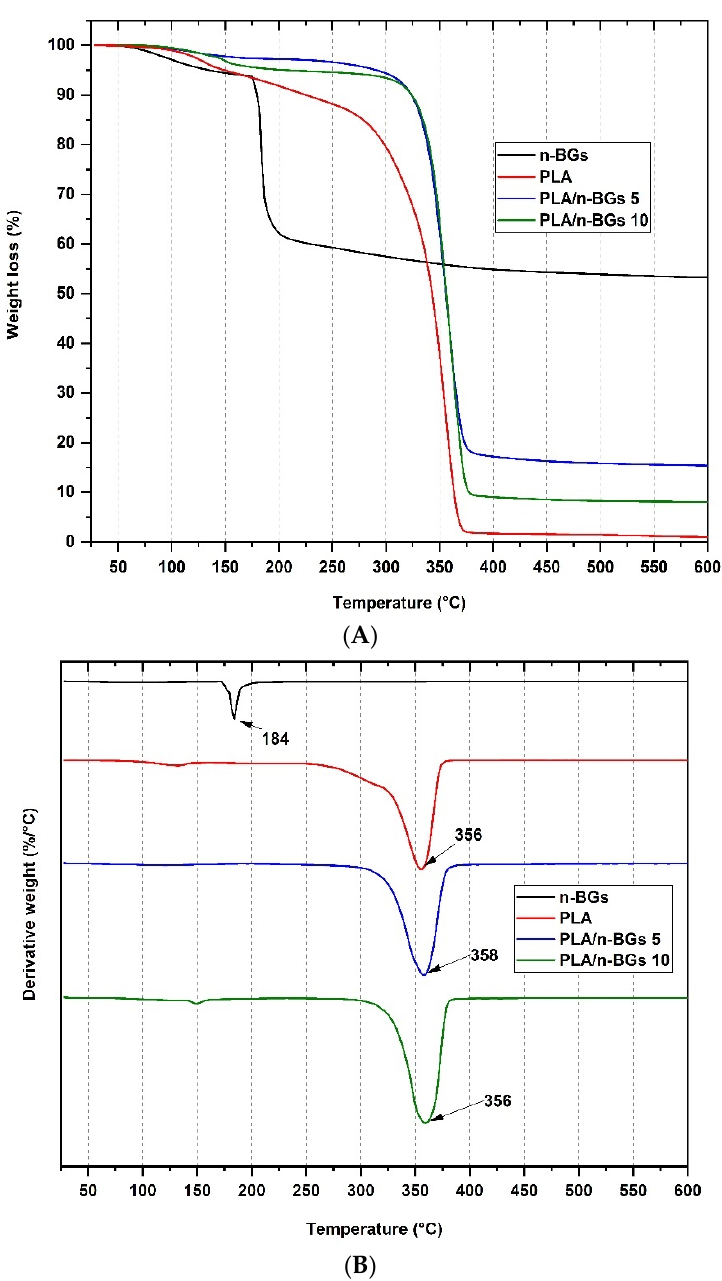
Figure 6. TGA and DTGA analysis of the nanocomposites of ( A ) neat PLA, PLA/n-BGs 5 wt.%, and PLA/n-BGs 10 wt.%. ( B ) Derivative TGA of neat PLA, PLA/n-BGs 5 wt.%, and PLA/n-BGs 10 wt.%.